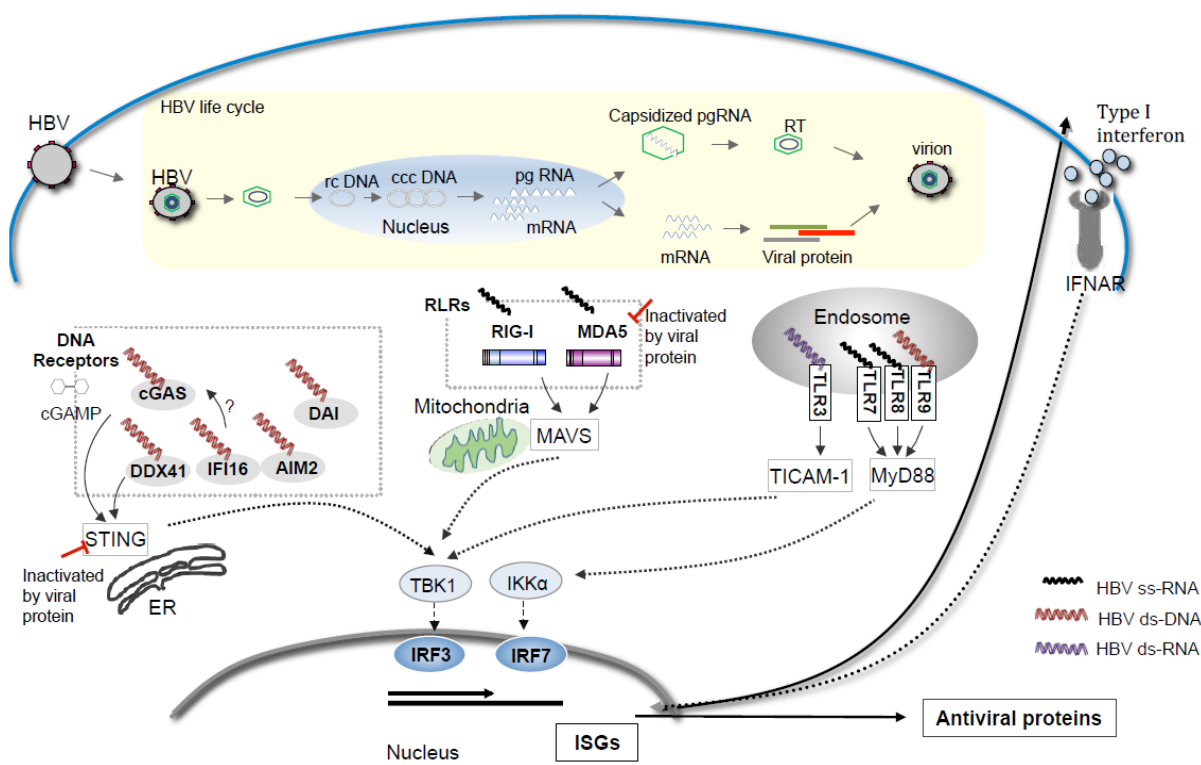
Figure 1. Possible Nucleic acid sensors participation in HBV pattern sensing in the life cycle of HBV. Various forms of nucleic acid are generated during the life cycle of HBV including the single stranded RNAs, double-stranded rc DNA/ccc DNA, or the double stranded RNAs. The cytosolic DNA receptors including cGAS, DDX41, IFI16, AIM2 and DAI may recognize the cytosolic DNA and activate the ER bound STING-TBK1-IRF3 axis to induce type I IFN production. While the RIG-I-like receptors (RLRs) including RIG-I and MDA5 activate the TBK1-IRF3 axis via mitochondria bound MAVS as adaptor protein upon the binding to cytosolic RNA. The four Toll-like receptor (TLR) family members: TLR3, TLR7/8 and TLR9 are located in the endosome, where they detect double stranded RNA, single-stranded RNA or non-methylated CpG DNA, respectively, leading to activation of TICAM-1 and MyD88 dependent pathways and the up-regulation of type I IFN. The HBV viral proteins seem to block the activation of the cytosolic RNA-sensing pathway as well as the cytosolic DNA-sensing pathways. Studies show that the HBV DNA could activate the ER bound STING and TBK1 in the hepatocytes and cytosolic RNA-sensing is dispensable in limiting the HBV propagation in the mice receiving liver specific in vivo transfection of the replicative HBV genome